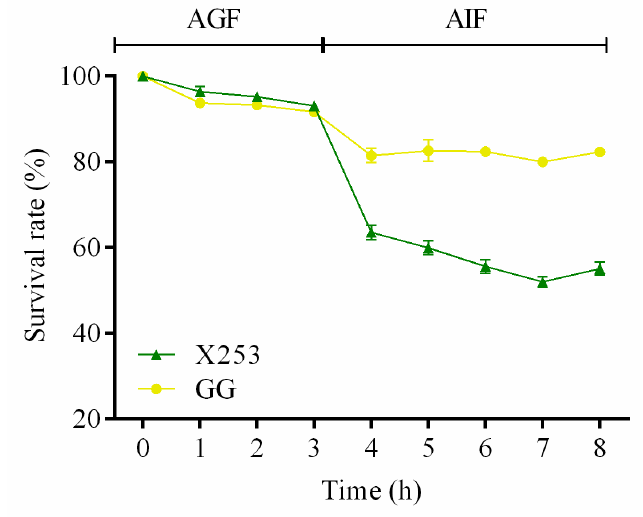
Figure 4. Artificial gastric fluid and intestinal fluid tolerance of L. rhamnosus X253 and GG: Survival rate of L. rhamnosus X253 and GG (10 8 CFU/mL) in artificial gastric fluids at pH 3.0, followed by artificial intestinal fluids at pH 8.0.